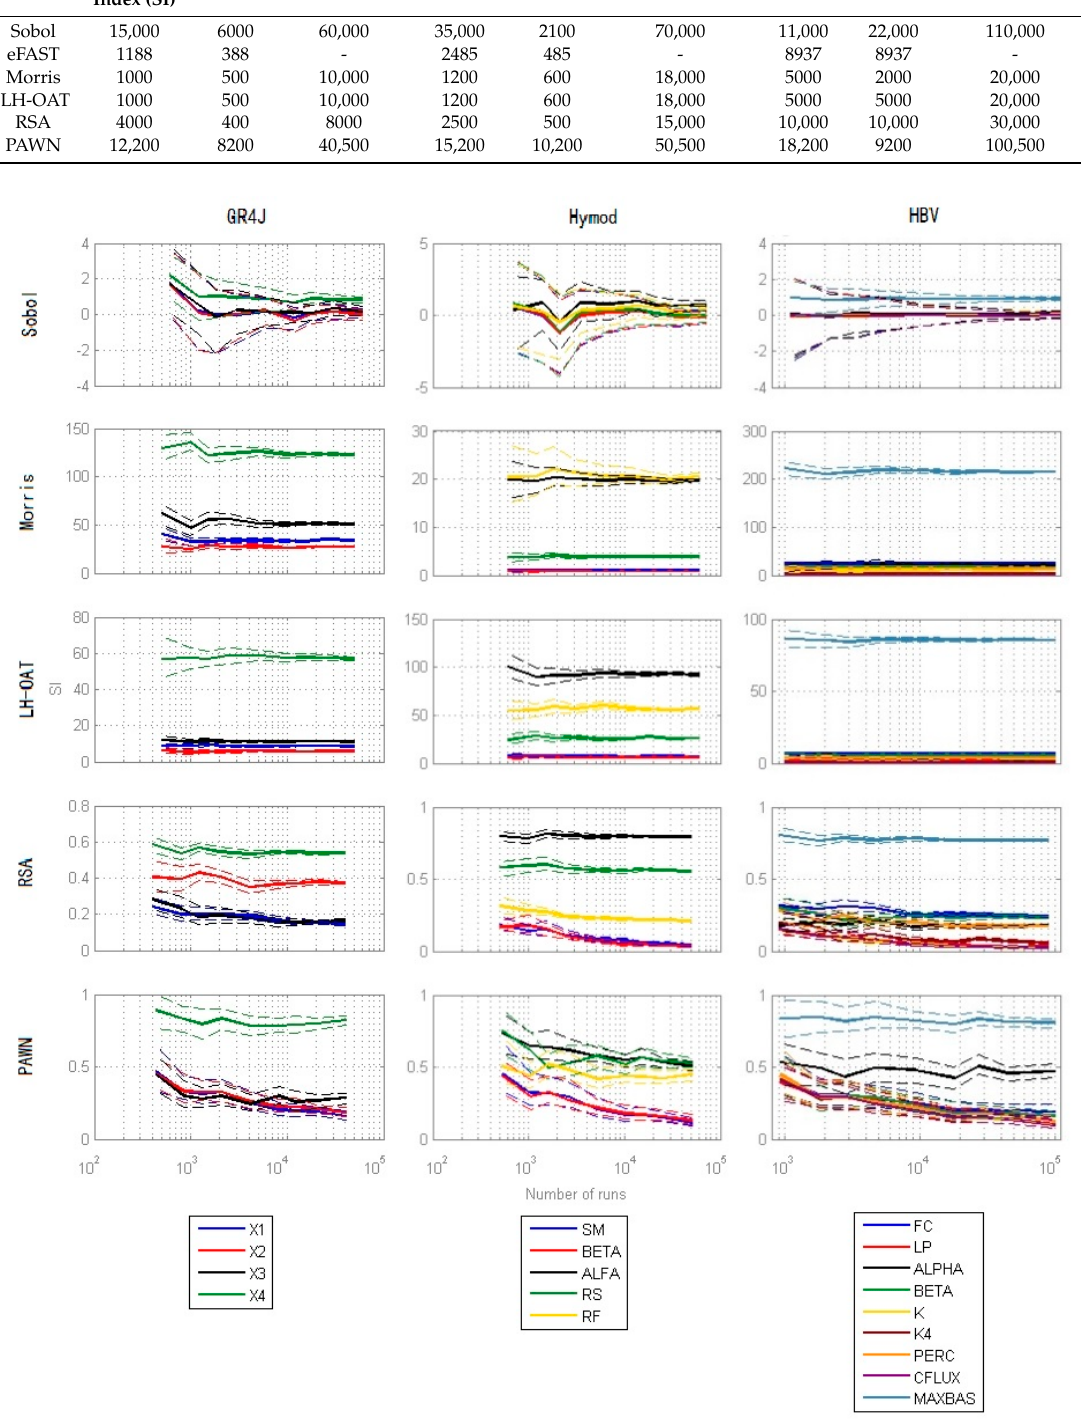
Figure 12. Estimate of mean and 95% Confidence Interval (CI) of different Sensitivity Analysis (SA) methods with different number of runs for GR4J ( left column ), Hymod ( mid column ) and HBV ( right column ) model, the horizontal axis is in log scale.